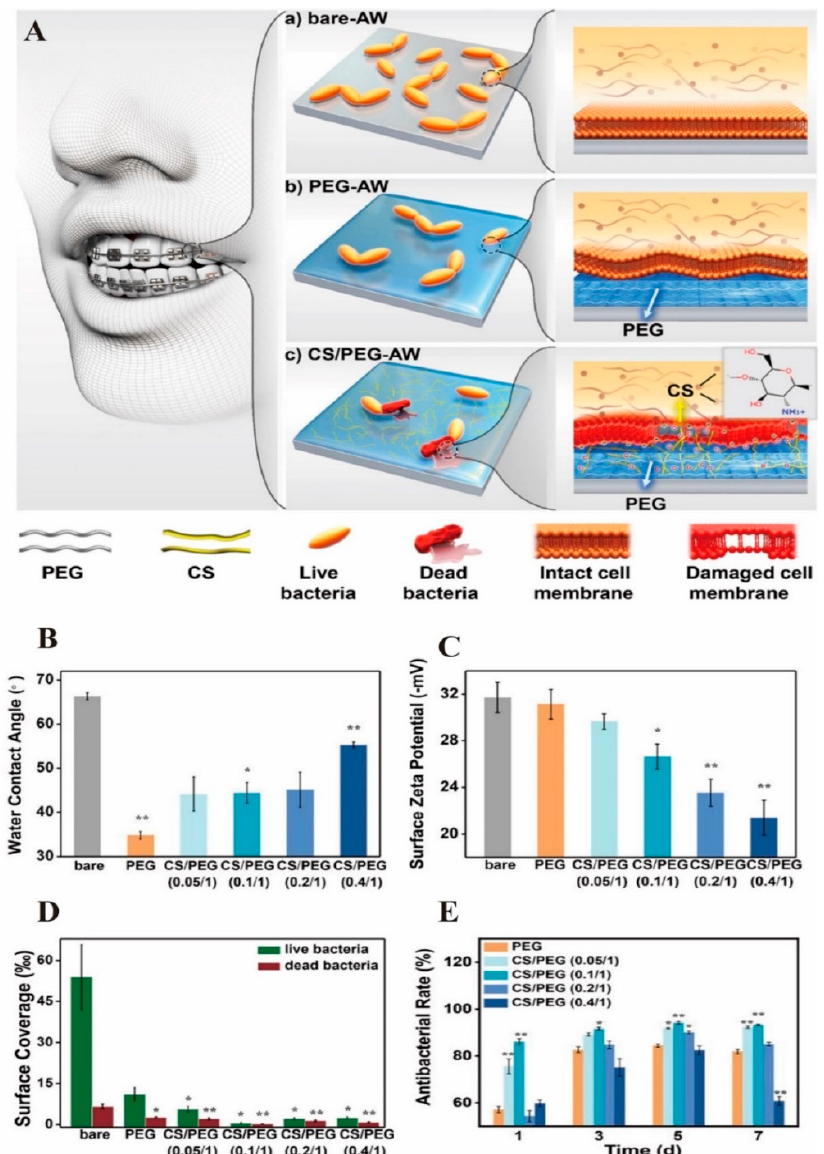
Figure 4. ( A ) Schematic diagram of antiadhesive and antibacterial composite hydrogel coatings: ( a ) Bacteria accumulated significantly on bare stainless steel AW, ( b ) PEGylation of stainless steel AW can significantly reduce bacterial adhesion, ( c ) stainless steel AW with CS/PEG hydrogel coating has the ability to inhibit adhesion and antibacterial activity; ( B ) AW surface contact angle change; ( C ) Surface zeta potential change; ( D ) Surface coverage of live and dead bacteria on materials; ( E ) Rate of long-term antibacterial effect against S. mutans . Reprinted with permission from ref. [69]. Copyright 2021 American Chemical Society. * p < 0.05; ** p < 0.01 from data obtained in the bare- AW